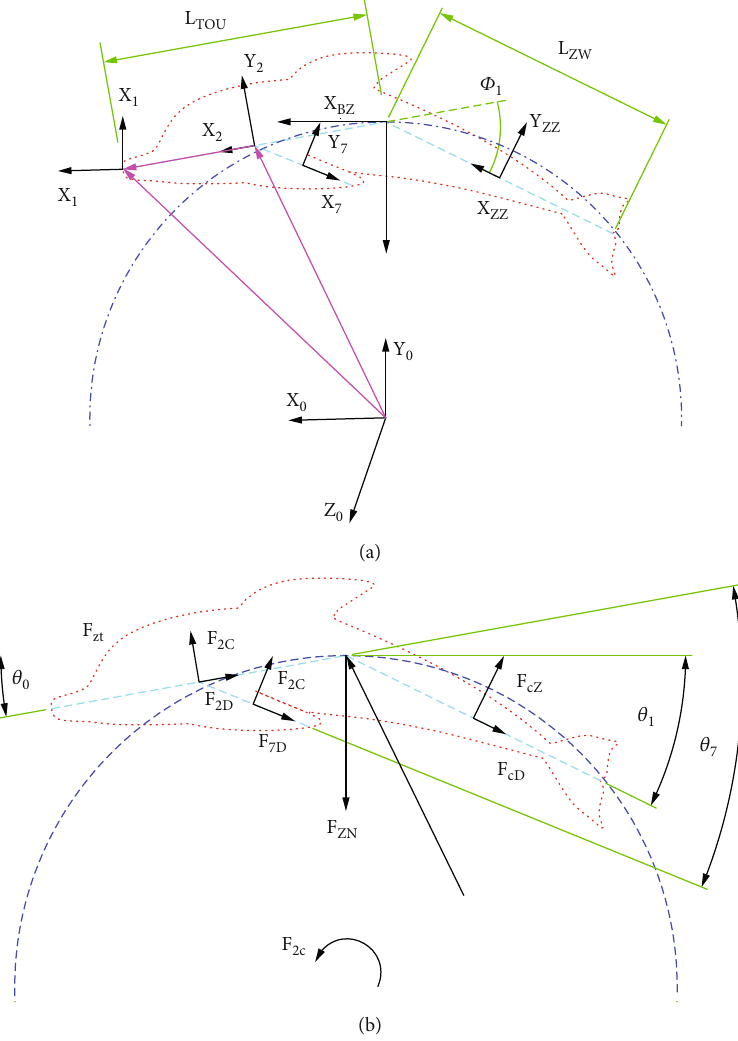
Figure 6: Diagram of dynamic analysis for C-turning. (a) Coordinate system for C-turning. (b) Force analysis for